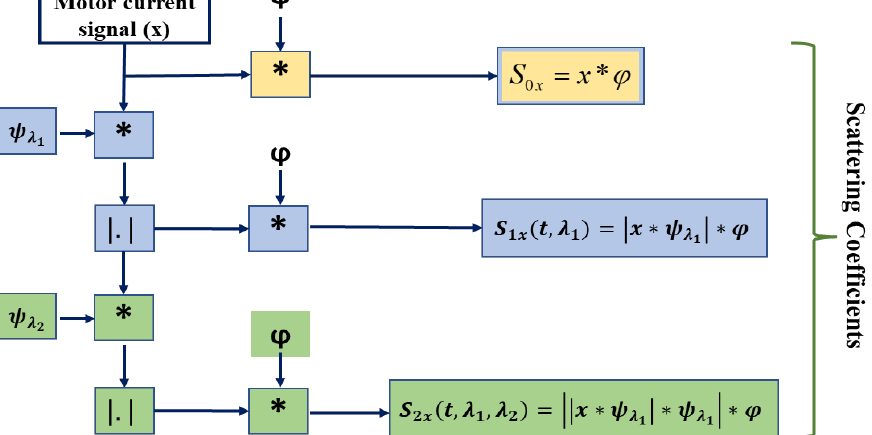
Figure 2. The schematic diagram of the feature extraction procedure with the second-order WST.